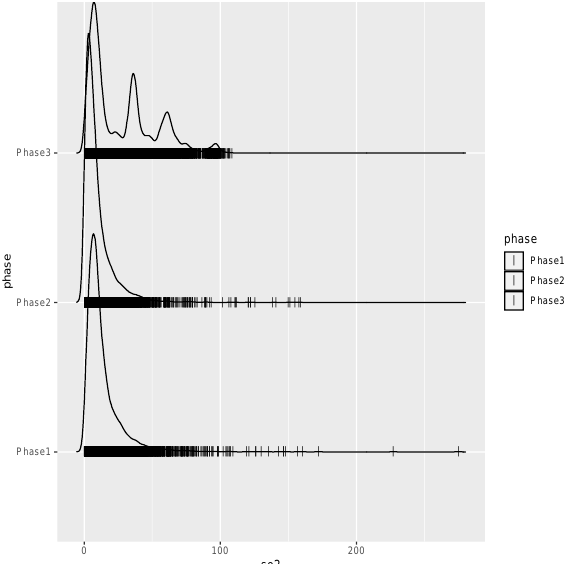
Figure 10. PD Fs of SO 2 ( µ g/m 3 ) w ith three Phases for K adikoy Station Figure 10. PD Fs of SO ( µ g/m 3 ) w ith three Phases for K adikoy Station Figure A5. PDFs of SO 2 ( µ g/m 3 ) with three Phases for Kadikoy Station. Figure A5. PDFs of SO 2 ( μ g/m 3 ) with three Phases for Kadikoy Station. 2 Figure A5. PDFs of SO 2 ( μ g/m 3 ) with three Phases for Kadikoy Station.